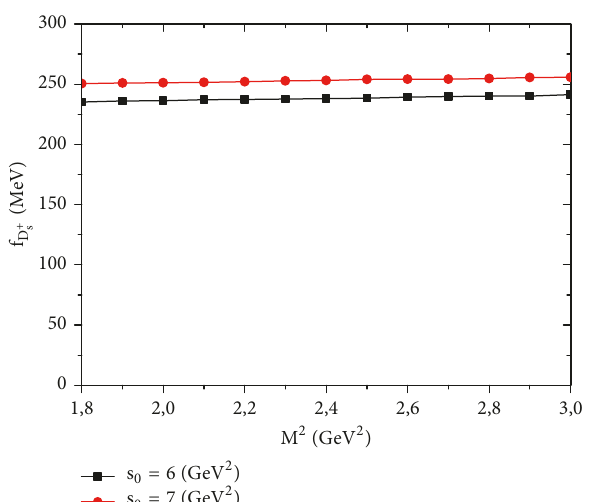
Figure 8: Borel parameter dependence of the 𝐵 0 푠 decay